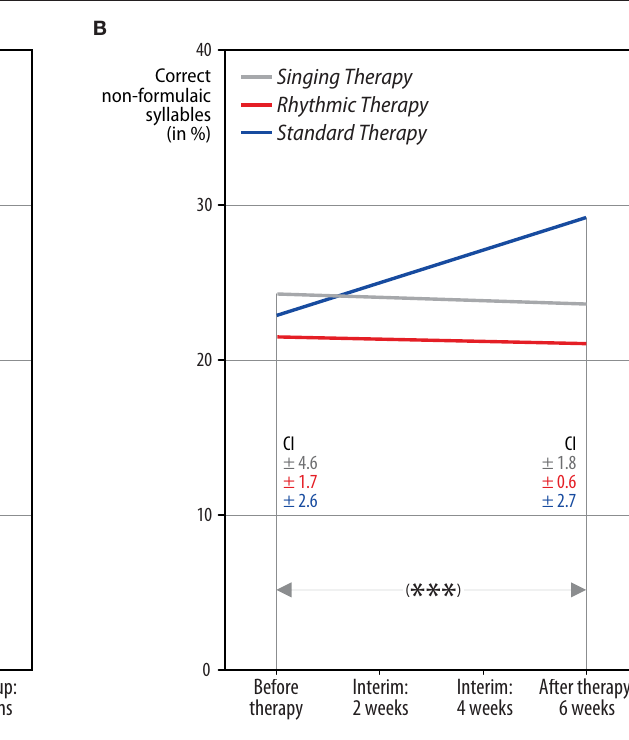
FIGURE 2 | Correctly produced formulaic and non-formulaic lyric syllables in each treatment group. The results yielded a significant interaction of time, treatment group, and lyric type ( ∗∗∗ p < 0 . 001). Panel (A) : both singing and rhythmic therapy patients improved their production of formulaic phrases (“Hello, everything alright? Everything’s fine ... ”). This progress occurred at an early stage of both therapies and was stable over time. Conversely, patients receiving standard speech therapy made less progress in the production of formulaic phrases. Panel (B) : standard therapy patients improved their production of non-formulaic speech (“Bright